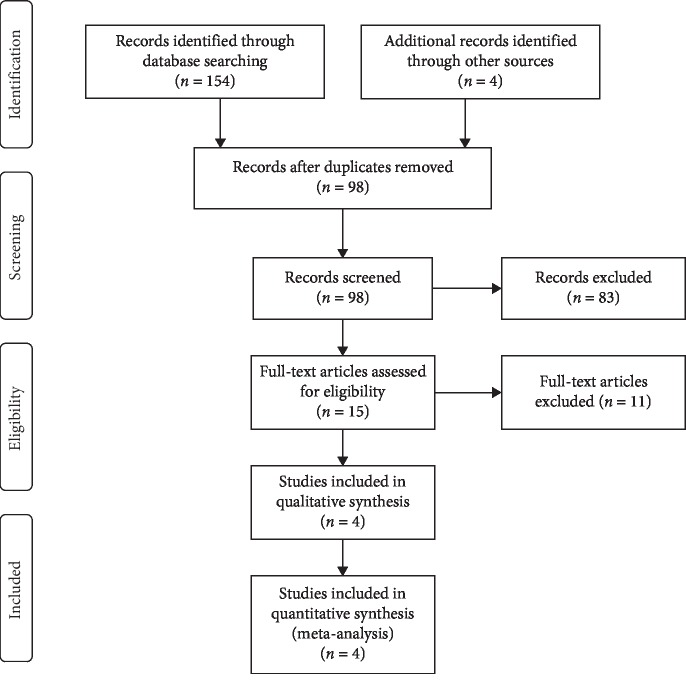
The flow diagram.